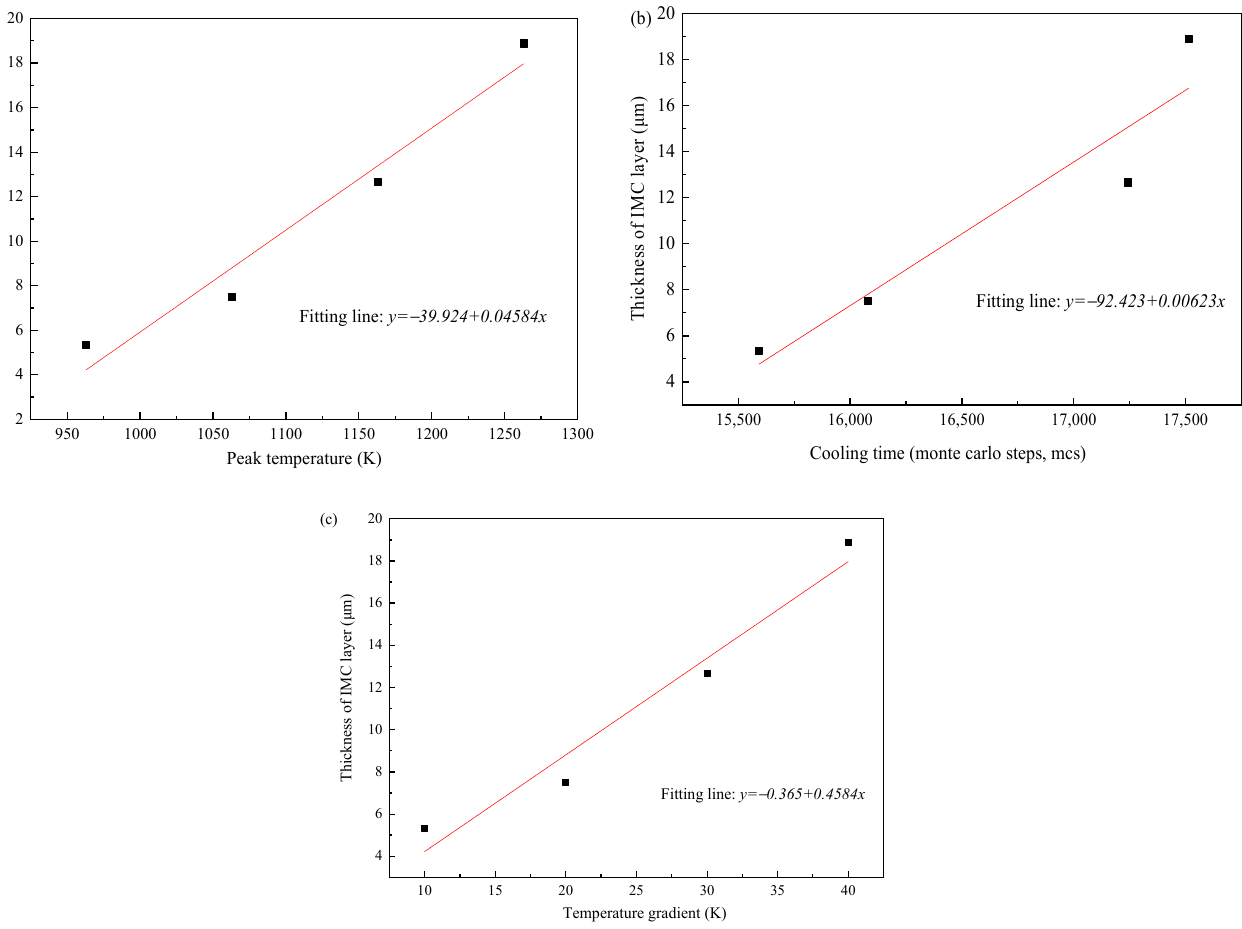
Figure 15. ( a ) Correlation between peak temperature and IMCs thickness, ( b ) correlation between cooling time and IMCs thickness, and ( c ) correlation between temperature gradient and IMCs thick- ness.